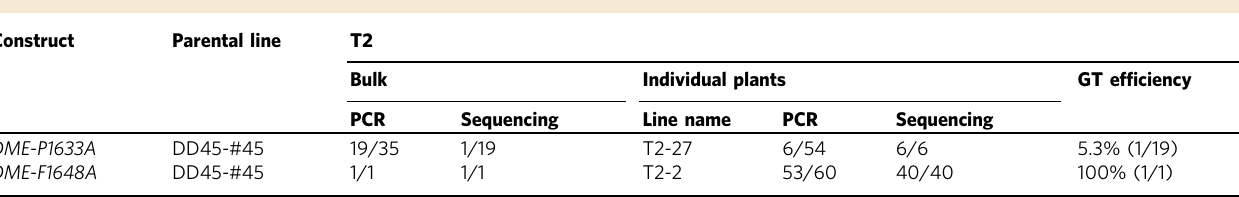
T2 bulk seedlings were genotyped by restriction digestion and PCR, and the positive samples were sequenced. For DME - P1633A , one of the 19 T2 bulk PCR positives had the P1633A amino acid substitution, and the rest had errors/mutations due to NHEJ. Fifty-four individual T2 plants from the positive line in T2 bulk screening were analyzed by restriction digestion and PCR, and six were found positive, and sequencing con fi rmed that all six had the P1633A substitution. For DME - F1648A , only one T2 population was obtained, which was found positive in the T2 bulk restriction digestion-PCR assay and sequencing showed that it was caused by F1648A substitution. Sixty T2 individual plants from this population were analyzed by restriction digestion-PCR and 53 were found positive. Forty of the 53 were tested by sequencing and all 40 were con fi rmed to have the F1648A Alternatively, HDR and the resulting GT may occur during the positive plants in T2 populations ranged from 4/59 to 53/60 reproductive stage of T1 plants, when the T-DNA is already (Tables 1 and 2). The data are consistent with heritable GT events stably integrated. Five GFP - DME heterozygous T2 plants showed segregation from the Cas9 transgene (Fig. 3e, f), indicating that heritable knock-in occurred in T1 plants. The frequency of GT-